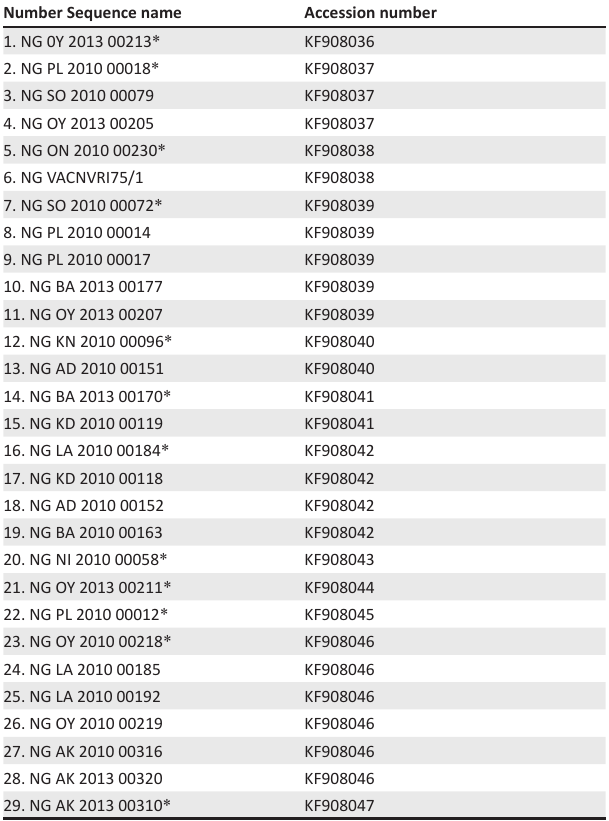
TABLE 3: National Center for Biotechnology Information GenBank accession numbers of sequences described in this study. Number Sequence